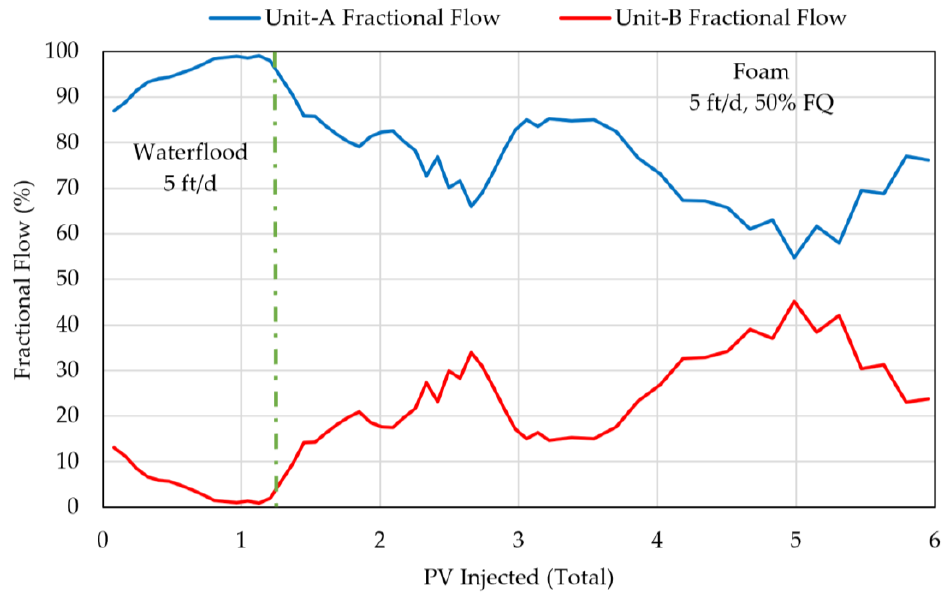
Figure 15. Fractional flow through Unit-A and Unit-B cores for DI-Exp 3.